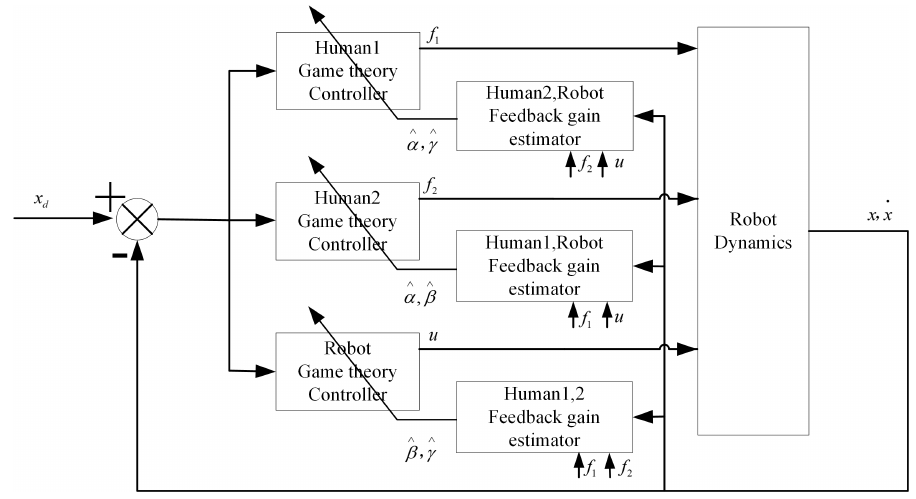
Figure 2. Control Architecture.